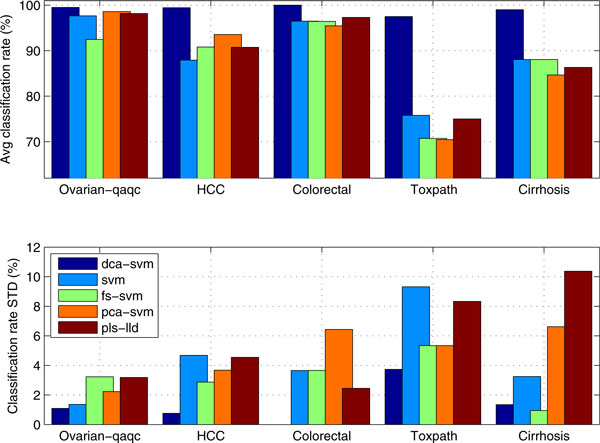
Comparing DCA-SVM based profile-biomarker diagnosis' average diagnostic accuracies and its standard deviations with those of other peers.